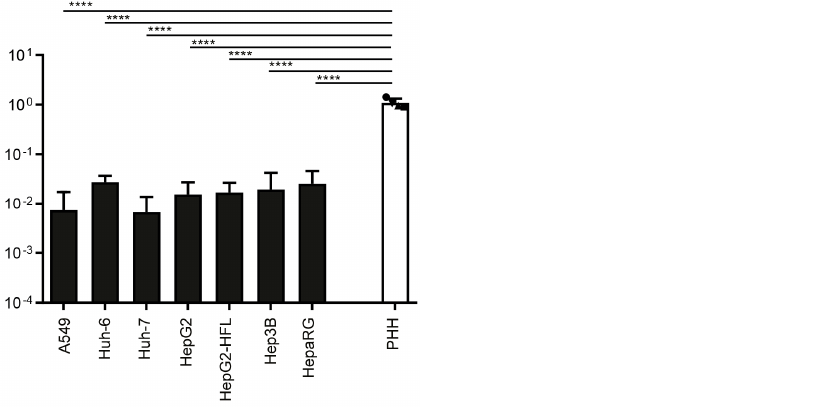
Figure 3. Transcript level of IFNAR in PHH and hepatoma cells. RNA expression of IFNAR in tested cell lines and in PHH derived from four different donors. mRNA expression was measured by qRT-PCR as described in Figure 1a. One-way ANOVA, followed by Dunnett’s multiple comparison test **** p < 0.0001.